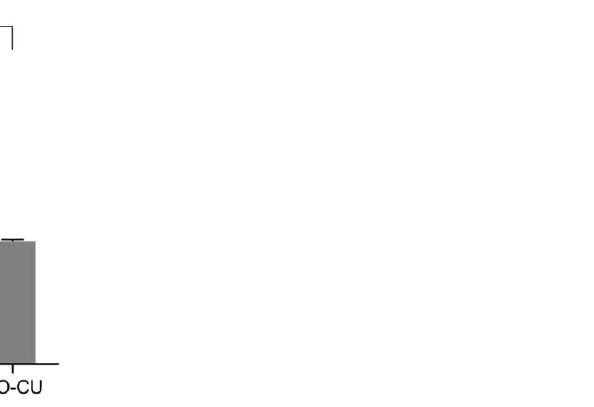
6 of 19 Figure 3. Growth curve of C. parapsilosis incubated with plastic (CTRL), GO, and GO/CU. O.D 630 was monitored every hour for 18 h. 2.2.2. Reactive Oxygen Species Assay To explore the early damage caused by the GO and GO/CU surfaces to C. parapsilosis , we measured intracellular ROS generation through the DCFDA. Candida cells were put in contact with 96-well plates covered by GO and GO/CU and without coating (control) for 6 h and then, the ROS production was measured. The GO-coated surface induced strong production of intracellular ROS compared to the plastic surface, as already reported in the